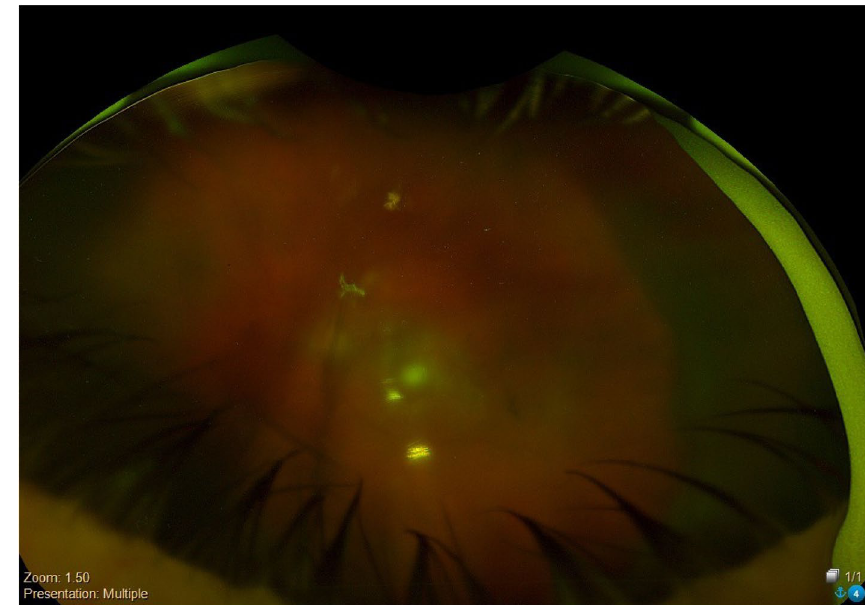
Fig. 3 Optos photo of left eye at time of recurrence of endophthalmitis